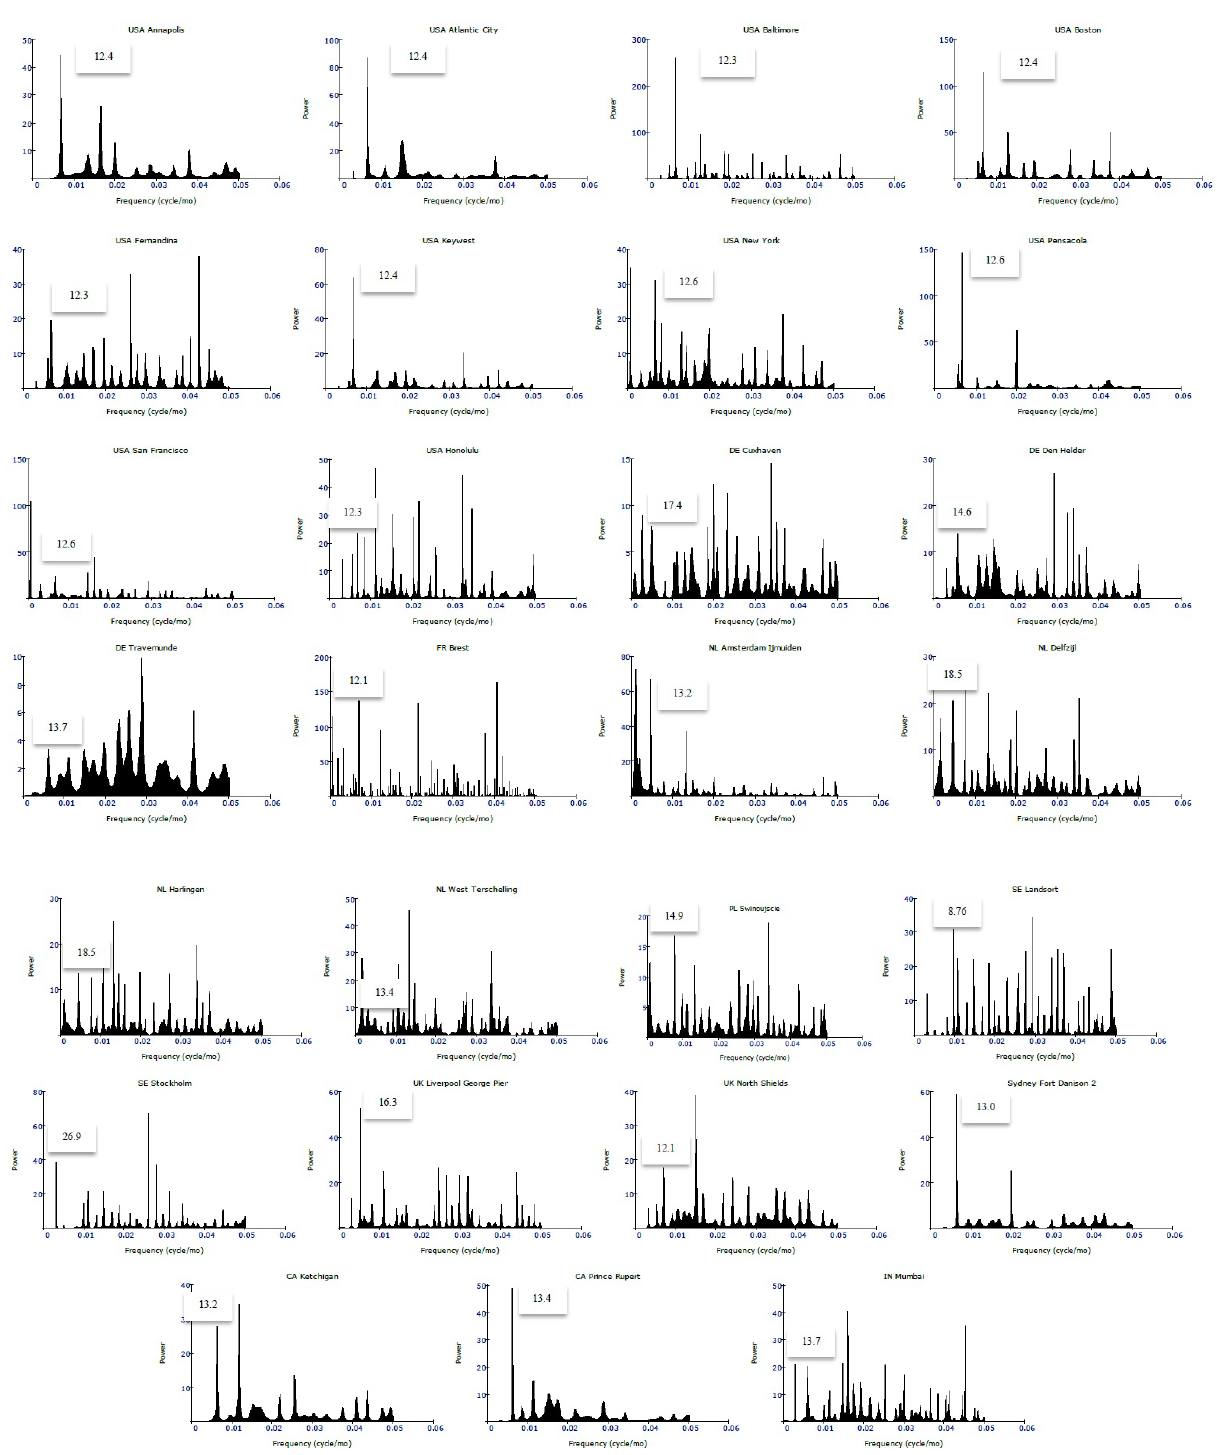
Figure 1: Power spectra (mm 2 ) of the monthly averaged RLR tide gauge records from the 27 globally distributed stations analyzed in this study. The data used are the residuals of the harmonic model, Eq. (1). Spectral analyses were carried out for residuals using Burg’s method (1967). Frequencies 0.001, 0.01, 0.02, 0.03, 0.04, and 0.05 cycle/mo. correspond to approximately 83, 8, 4, 3, 2, and 1.7 year periods,